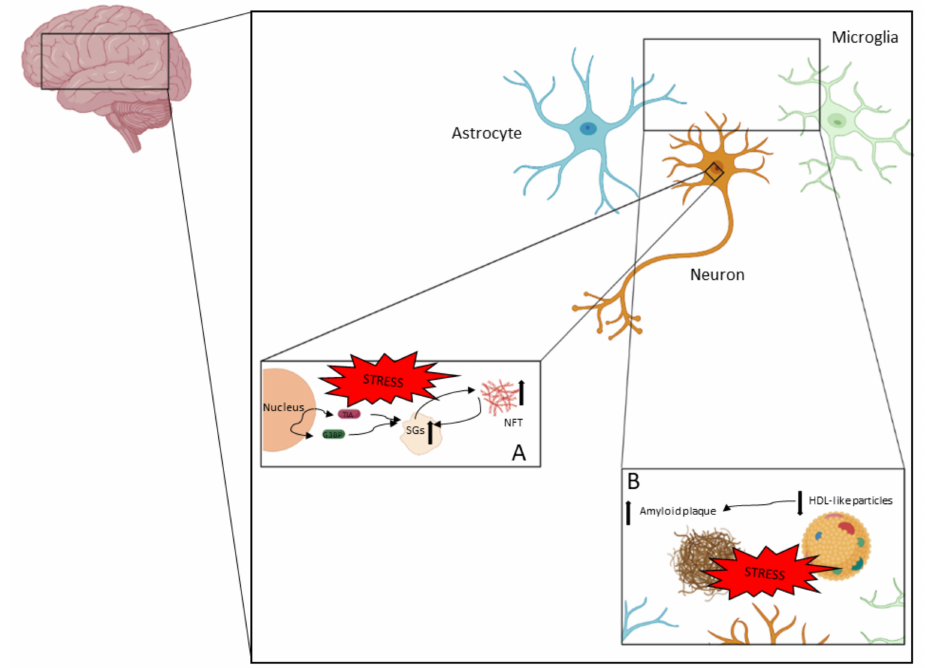
Figure 2. AD is a neurodegenerative disease in which neurodegeneration is driven by different processes. NFTs and amyloid plaques are the two main pathological features in AD. ( A ) NFTs are accumulations of hyperphosphorylated tau and other components. Tau hyperphosphorylation and aggregation could be driven by the pathological accumulation of SGs, which could be a consequence of chronic stress. ( B ) Amyloid plaque is an extracellular pathological feature (with intracellular intermediates) that mainly contains A β peptides. Amyloid plaque formation is highly associated with the clearance capacity of apolipoproteins contained in HDL-like